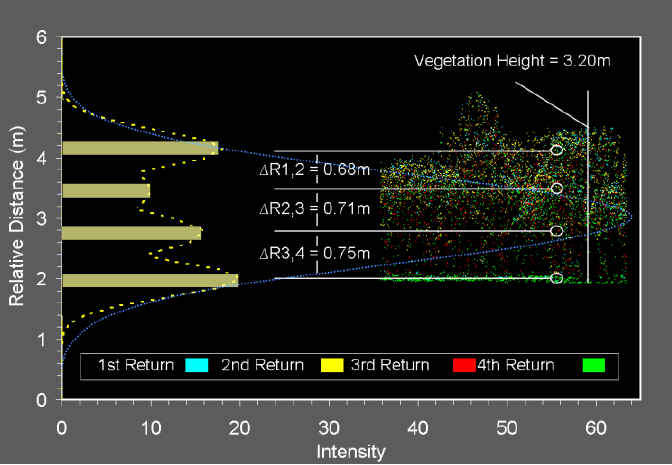
Figure 6. Graphic representation of the modeling approach of ALTM-Orion